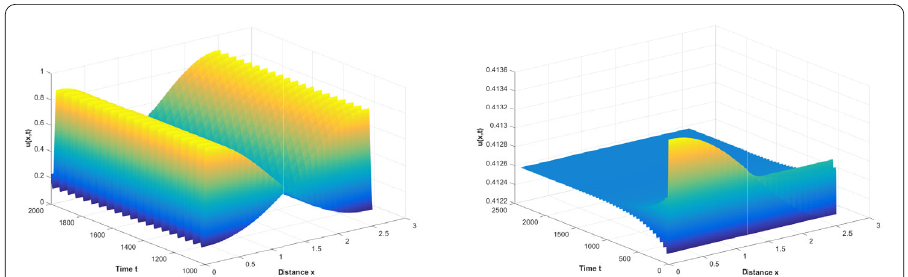
Figure 5 Numerical simulations for prey population with β = 0.5 τ = 12. (Left: model (1.4). Right: model (2.9))